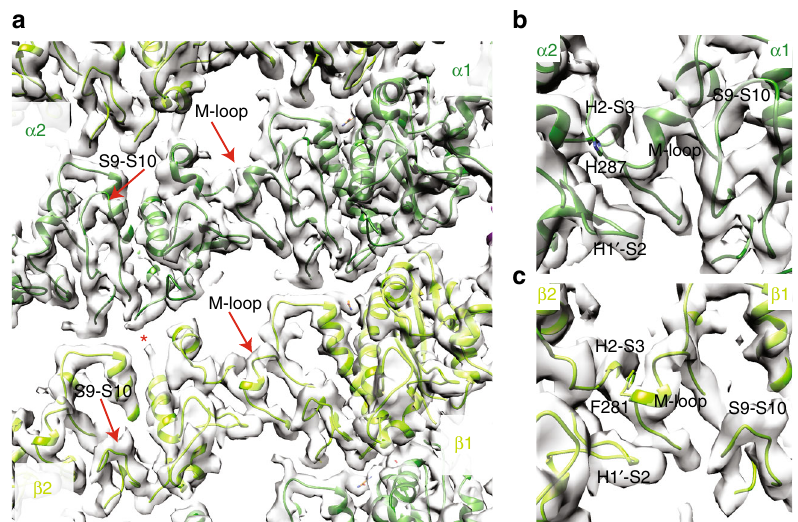
Fig. 5 Structure of lateral inter-proto fi lament contacts in S. pombe MTs. a View of inter-PF lateral contacts viewed from the MT lumen, with key secondary structure features highlighted. The S9 – S10 loop is 8 residues longer in α -tubulin allowing ready differentiation between α - and β -tubulin. Density corresponding to the H1 – H2 ′ loop in α -tubulin, which is less well de fi ned compared to β -tubulin, is indicated with a red asterisk. b Close up of α / α